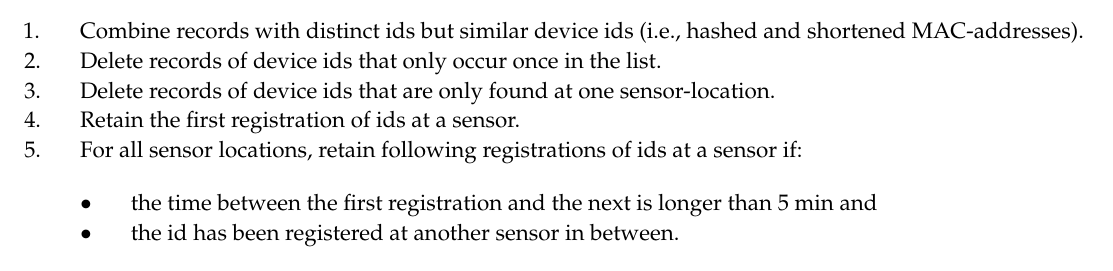
Table 2. Filtering procedure Wi-Fi sensor